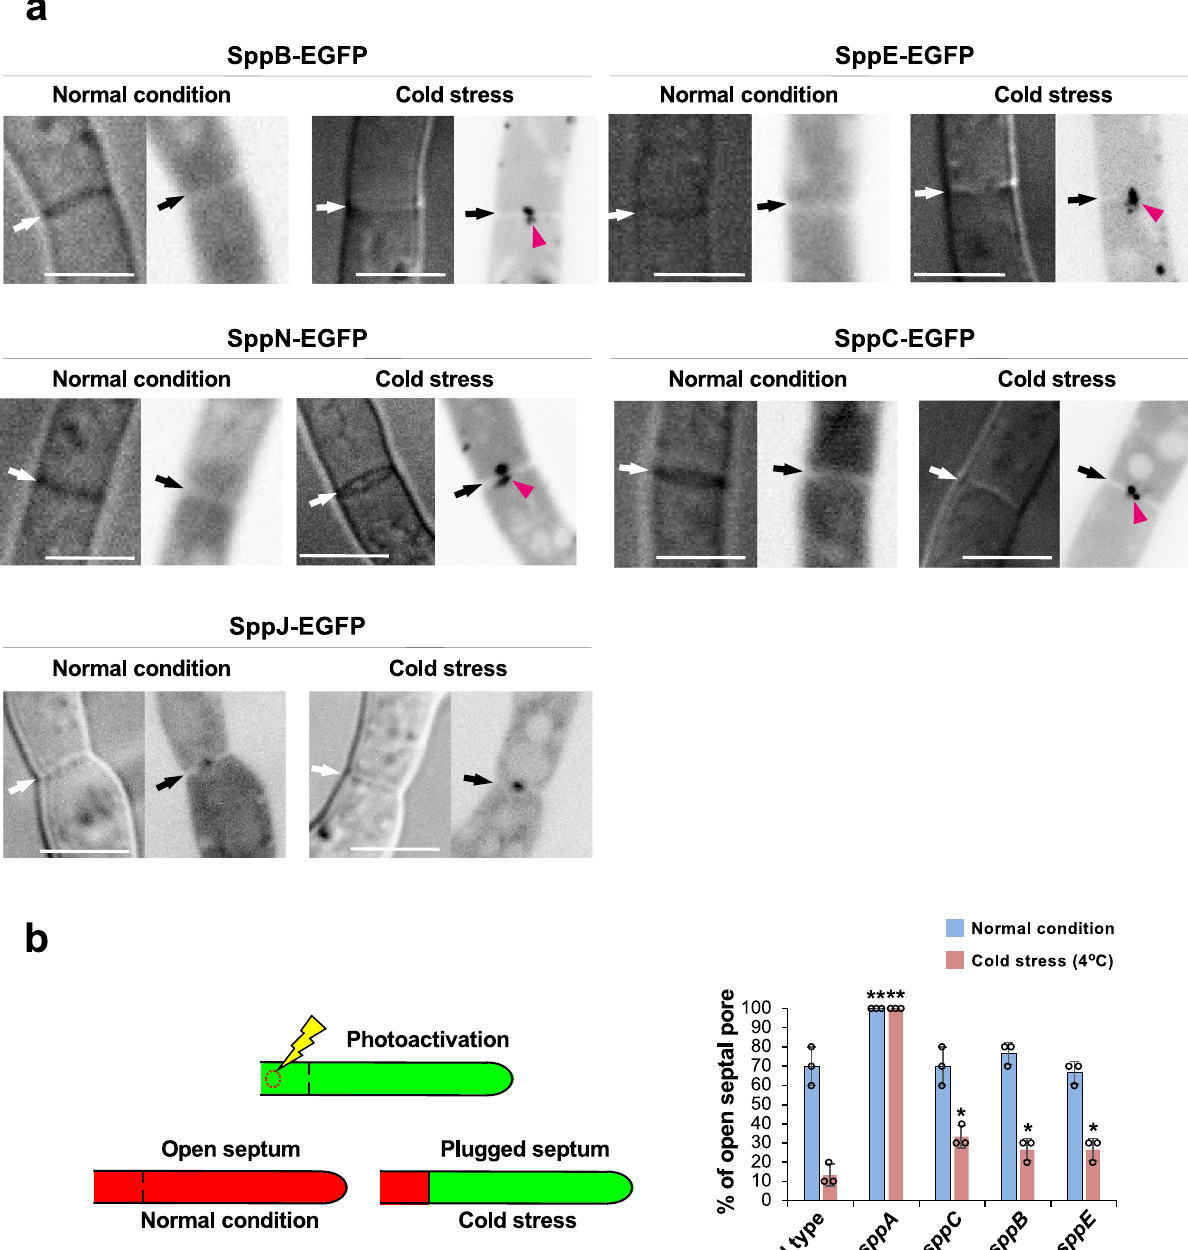
Fig.5|Regulationofcell-to-cellconnectivitybySPPproteinsundercoldstress. a Localization of SPP-EGFP-fusion proteins. Black/white arrows indicate septa, and pink arrowheads indicate septal pore accumulation. Single confocal fl uorescence images are shown. Scale bars, 5 μ m. b Models for photoactivation and cell-to-cell transfer of Dendra2 (left); quanti fi cation of transfer (right). Scale bars, 10 μ m. Dendra2 transfer through the septal pore was monitored at ten randomly chosen